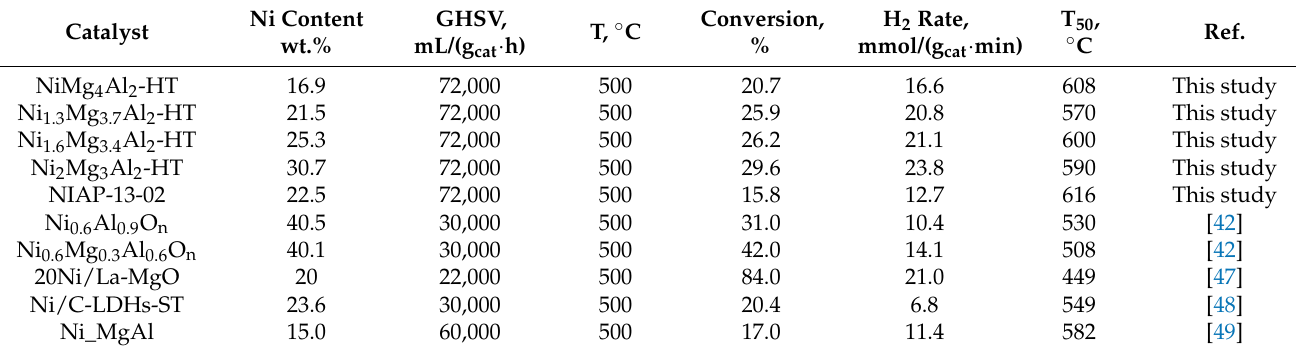
Table 3. Comparison of the NH 3 decomposition activity of nickel based catalysts (700 ◦ C, H 2